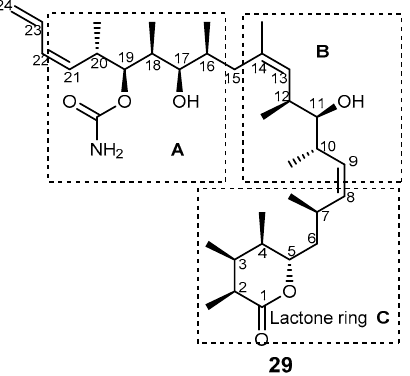
Figure 6. Structure of discodermolide ( 29 ) with highlighted subunits A, B, and C.